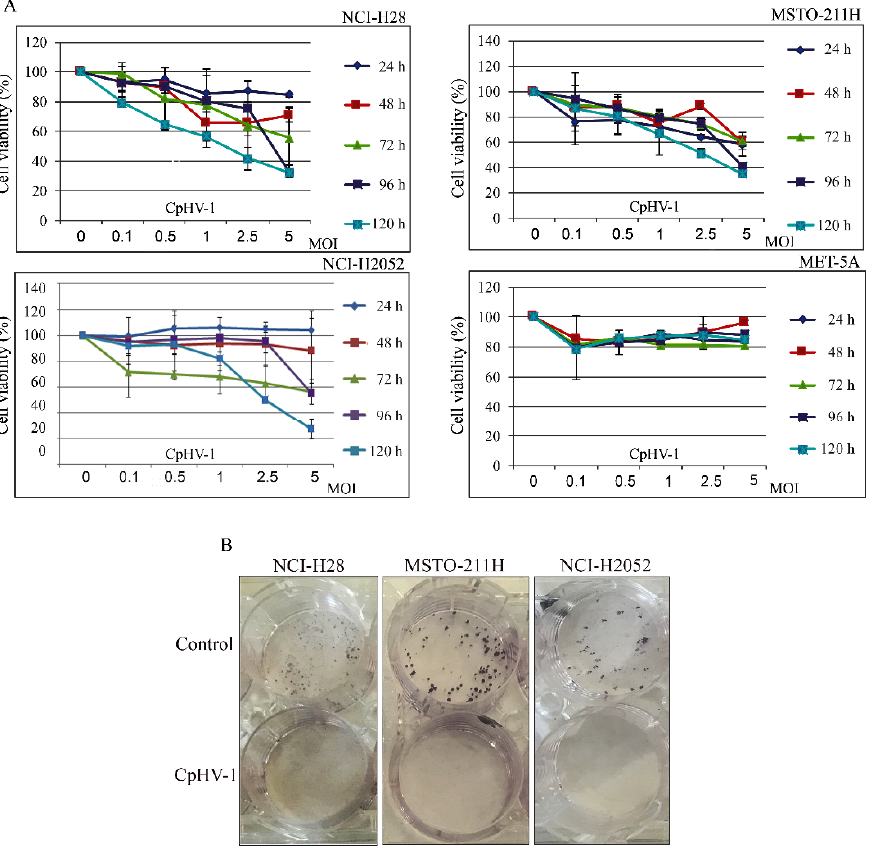
Figure 1. Effect of caprine herpesvirus 1 (CpHV-1) on mesothelioma cell viability and clonogenicpotential. ( A ) Dose-response curves reporting the effects of five different MOI (multiplicity of infection) of CpHV-1 on cell viability, evaluated through MTS assay at 24, 48, 72, 96, and 120 h post-infection. This assay was performed in three mesothelioma cell lines (NCI-H28, MSTO-211H, and NCI-H2052) and immortalized mesothelial cells (MET-5A). The results are reported as the means ± standard deviation of two independent experiments, each conducted in triplicate, and expressed as percentages of cell viability (calculated with respect to the untreated control cells). ( B ) Long-term CpHV-1 effects were assessed by clonogenic assay. Colonies were stained with crystal violet 10 days after a 72 h treatment with CpHV-1 (5 MOI). Representative plates, out of two (MSTO-211H) or three (NCI-H28, NCI-H2052) independent experiments are